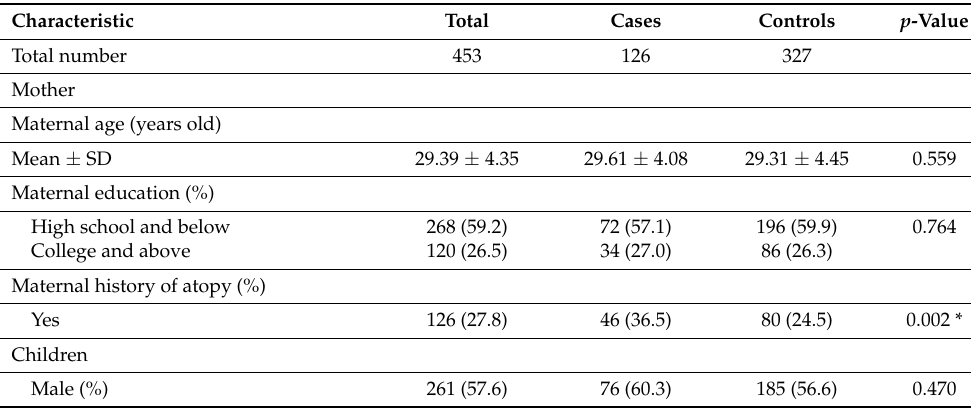
Table 1. Characteristics of the study